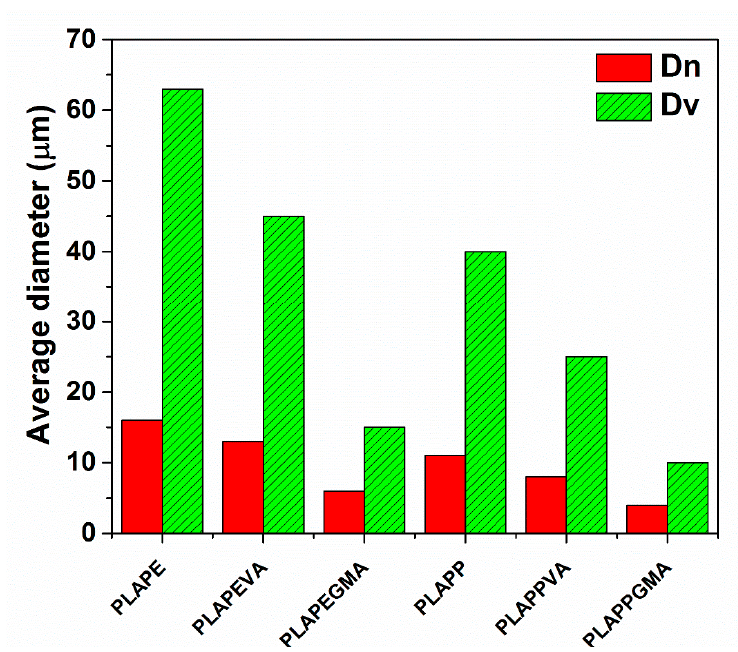
Figure 3. Variation of (cid:1830) (cid:3041) and (cid:1830) (cid:3049) of the dispersed phase in the PLA/POE blends